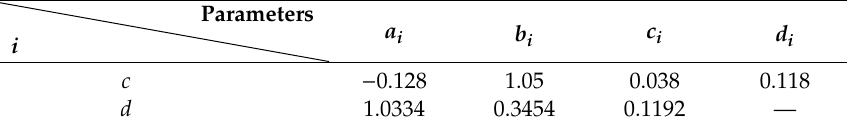
Table A1. Fitting parameters of charge-discharge e ffi ciency η .